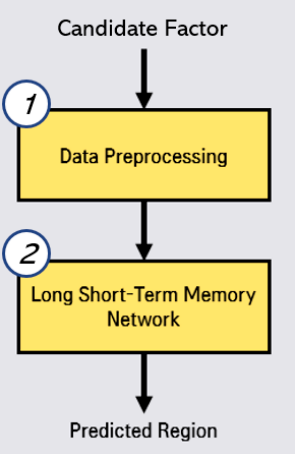
Figure 3. Process of outbreak region prediction for hepatitis A.